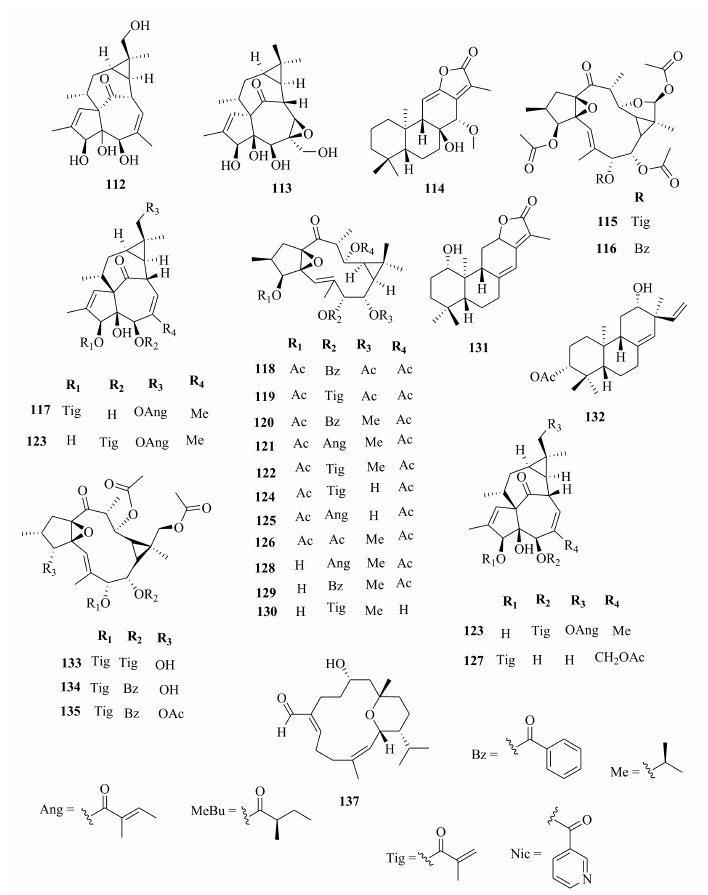
Figure 6. Chemical structures of Euphorbia ingol and ingenol